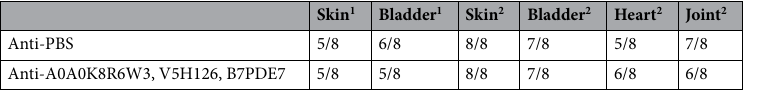
Table 2. Number of Borrelia afzelii -infected mice as determined for each organ. Borrelia afzelii infection as determined by culture 1 or qPCR 2 and shown as number of positive mice/total